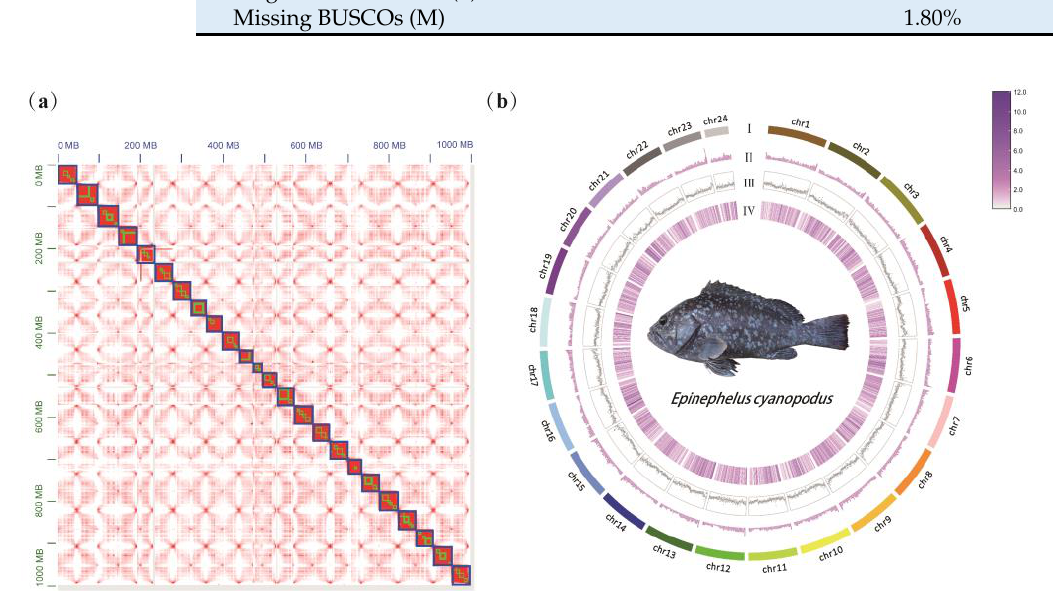
Figure 1. Genomic information visualization of E. cyanopodus : ( a ) Hi-C heatmap of E. cyanopodus genome assembly; and ( b ) genome characteristics of E. cyanopodus : (I) represents chromosome; (II) represents GC content; (III) represents the density of repeat sequence on each chromosome, and (IV) represents gene density on the chromosome.